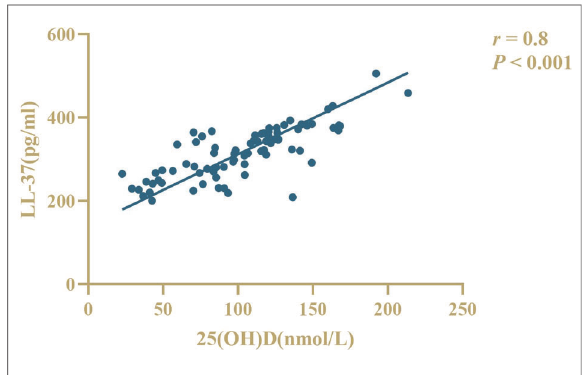
FIGURE 2 Correlation analysis of serum LL-37 and 25(OH)D levels in patients.